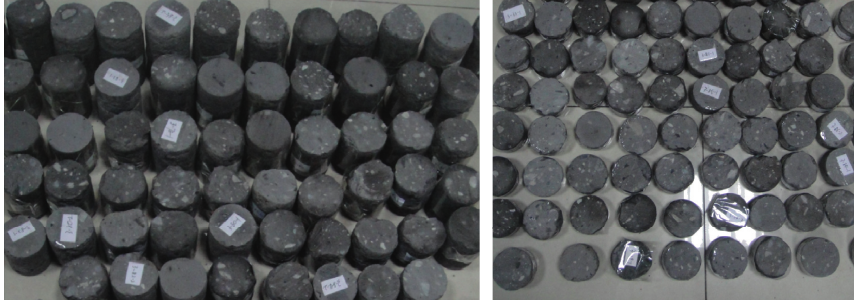
Figure 3: Standard samples after cutting.